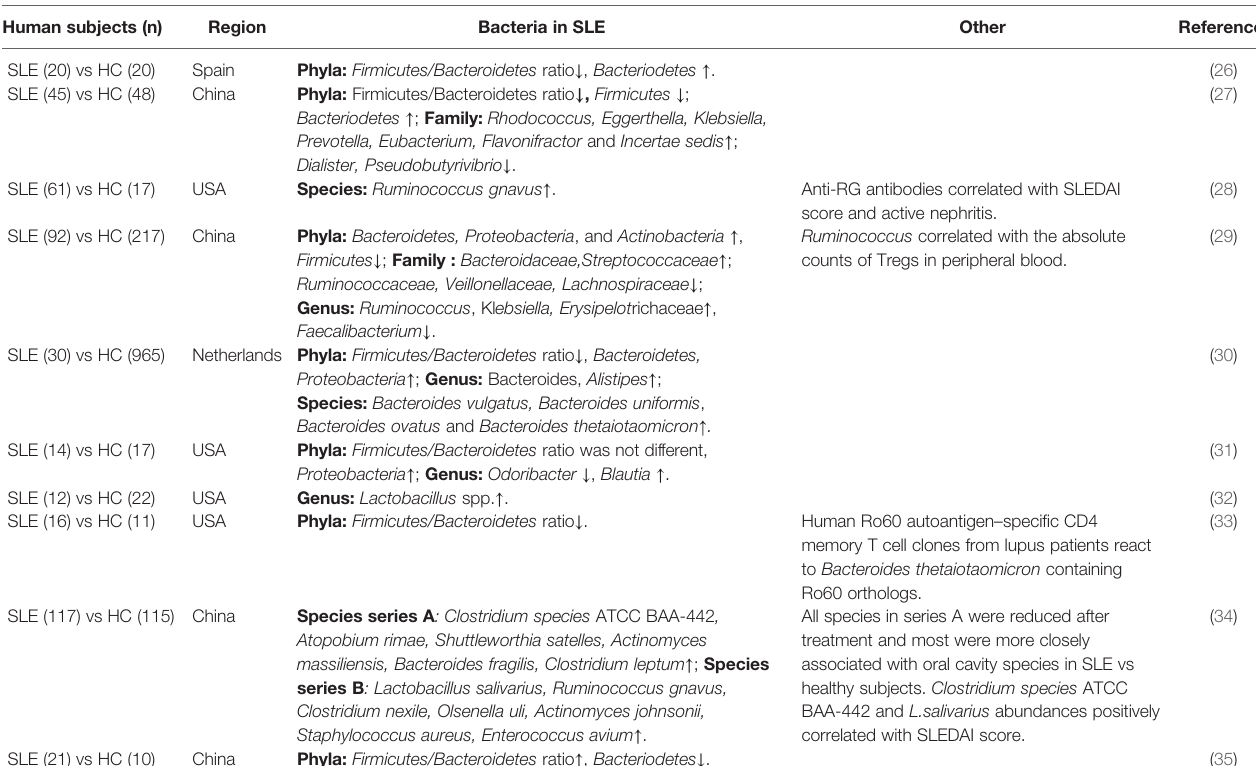
TABLE 1 | Microbiota alternation in patients with SLE. Human subjects (n) Region Bacteria in SLE